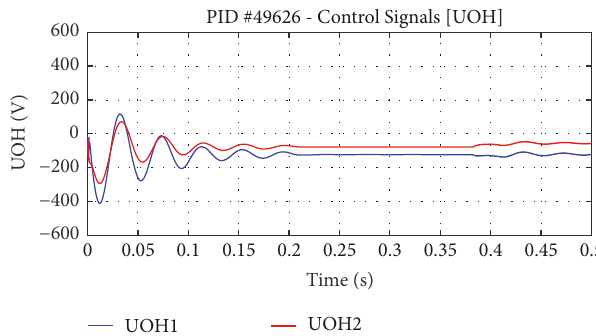
Figure 12: PID integral error (Shot #57587).